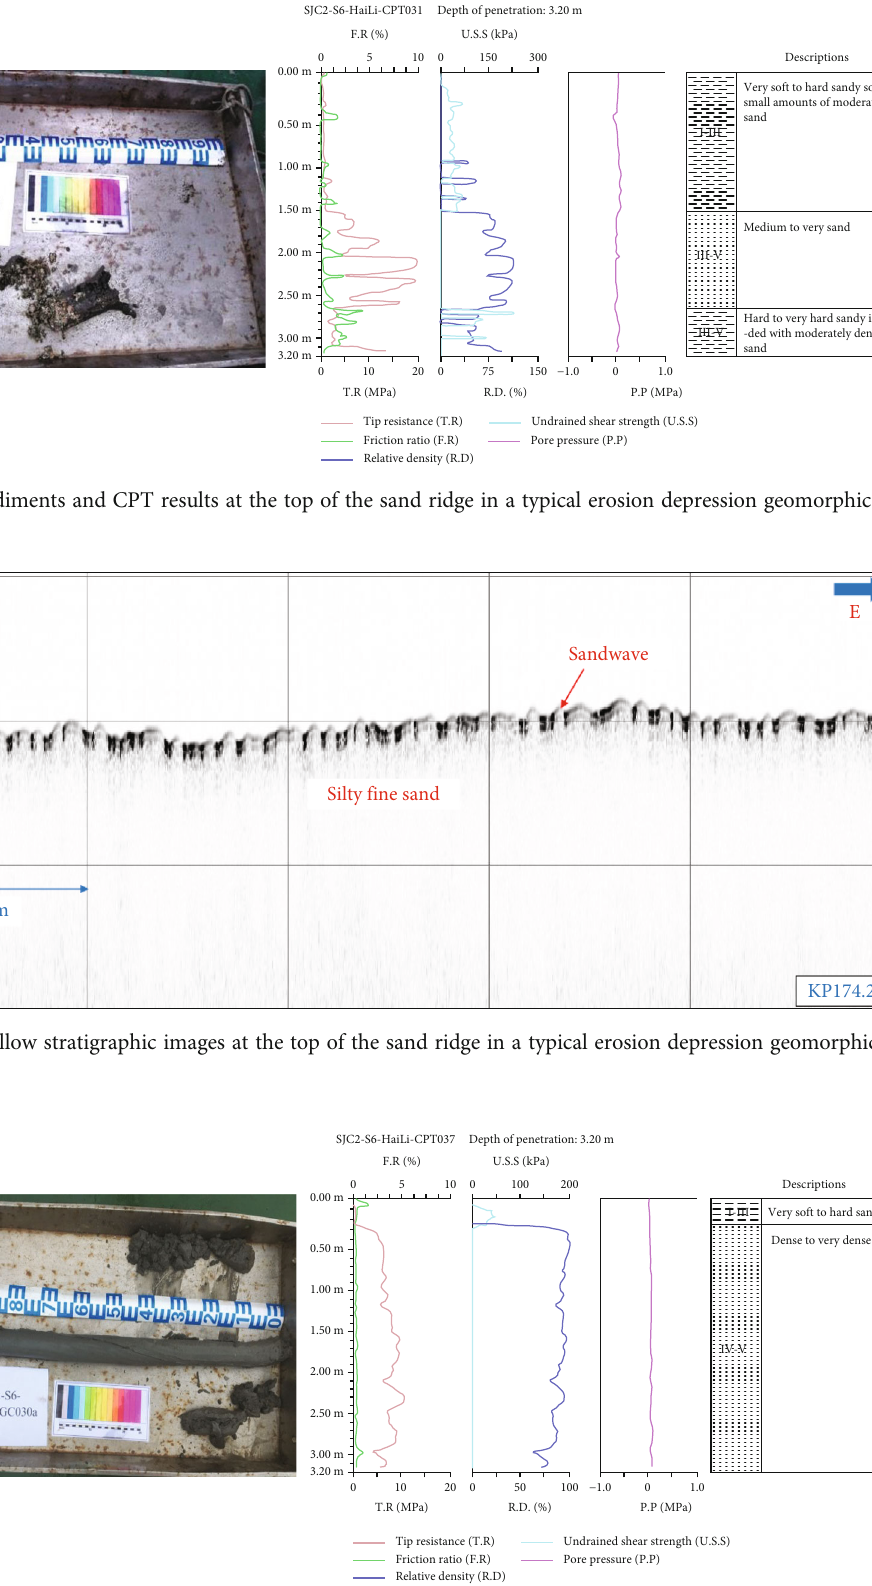
Figure 15: KP165-typical sediments and CPT test results on the outer edge of the continental